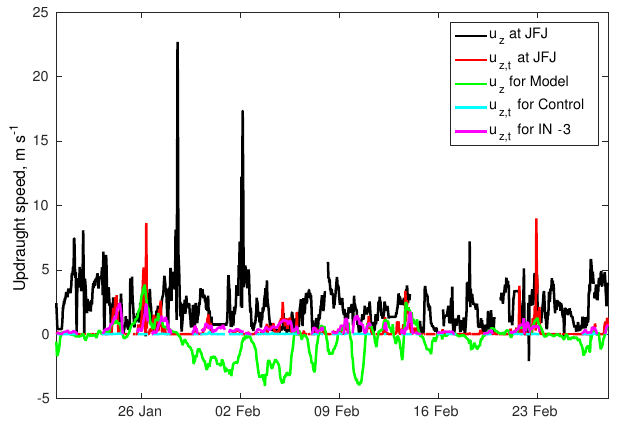
Figure 7. Analysis of vertical wind speed u z with the updraught threshold required for the presence of mixed-phase cloud for both measurements at Jungfraujoch and the control and IN-3 simula- tions. The updraught threshold is calculated as defined by Eq. (2), which is adapted from Korolev and Mazin